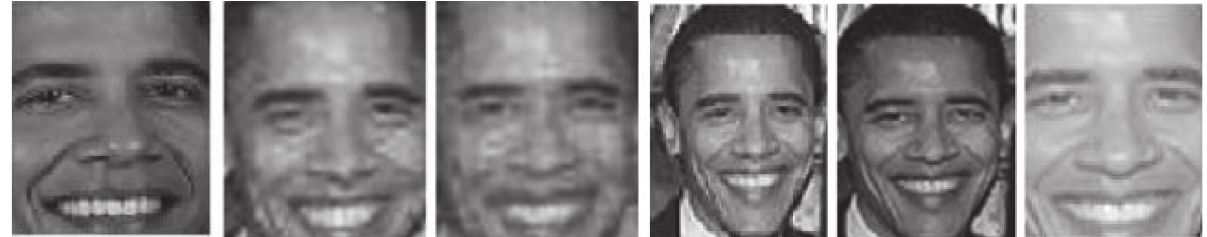
Figure 1: 1 st column, corrupted video face image; 2 nd column, the low-rank component by [31]; 3 rd column, the low-rank component by [30]; 4 th column, the low-rank component by [38]; 5 th column, the low-rank component by [39]; 6 th column, the low-rank component by the proposed method.